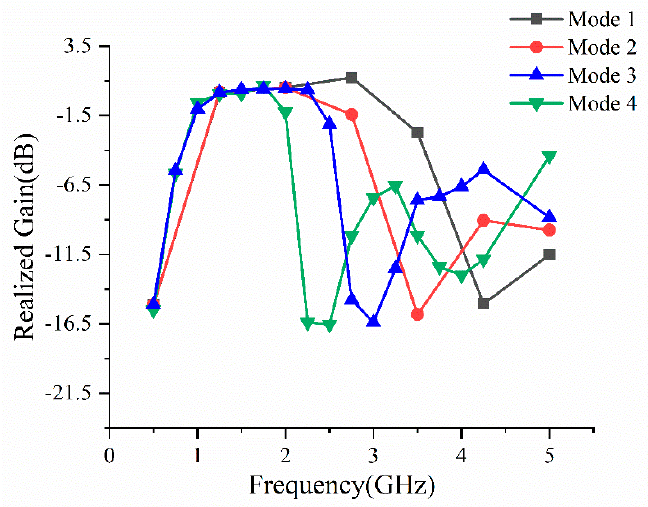
Figure 10. Measured realized gains of the proposed antenna.